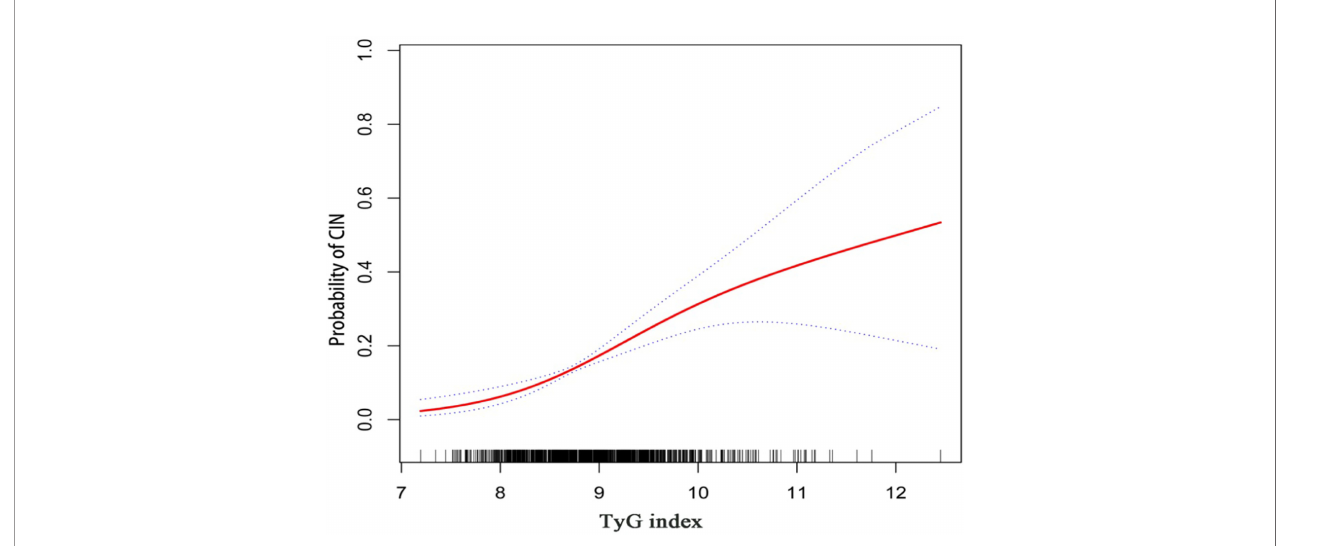
FIGURE 3 | Generalized additive model plot for the relationship of the TyG index with CIN. Adjusted for confounding factors including age, female, BMI, SBP, DBP, hypertension, diabetes mellitus, CKD, NSTEMI, hydration, diuretics, the dose of contrast agent, leukocyte count, hemoglobin, SCr, LDL-C, HbA1c, multiple vessel disease, Gensini scores, oral hypoglycemic drugs, and ACEI/ARB.